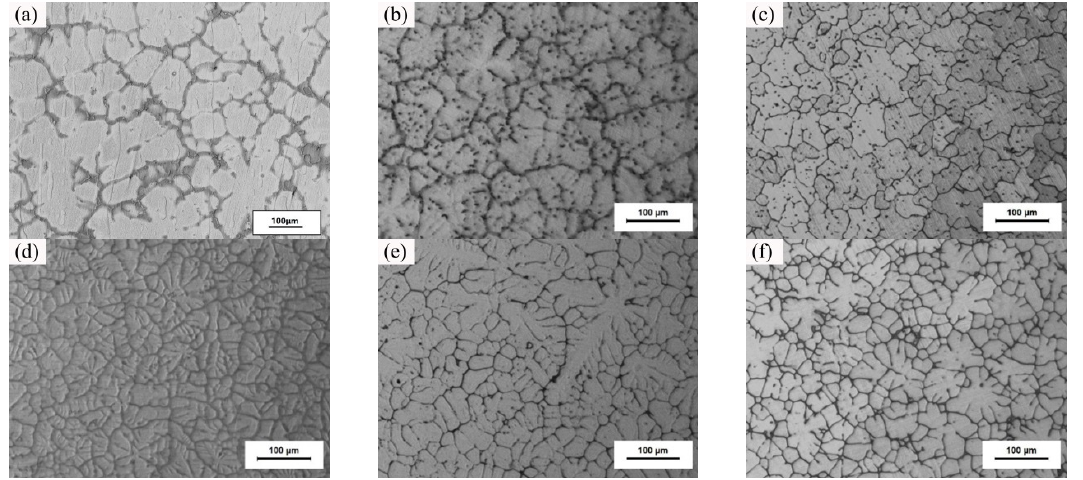
Figure 4. The optical microstructure of the gravity casting part and the liquid forging parts with different Y-element contents: ( a ) Mg-0YG, ( b ) Mg-0YL, ( c ) Mg-1YL, ( d ) Mg-2YL, ( e ) Mg-3YL, ( f ) Mg- 4YL.